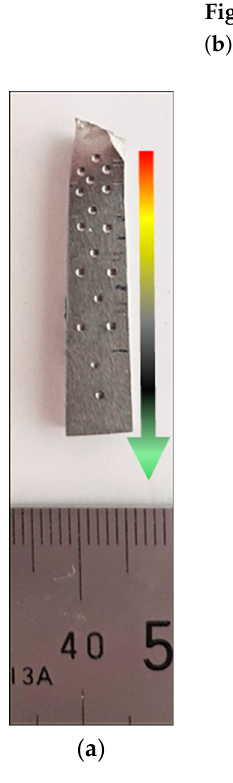
Figure 10. HCF tested specimen: ( a ) gage part of the specimen after indentation tests; ( b ) and indentation force–displacement plots.